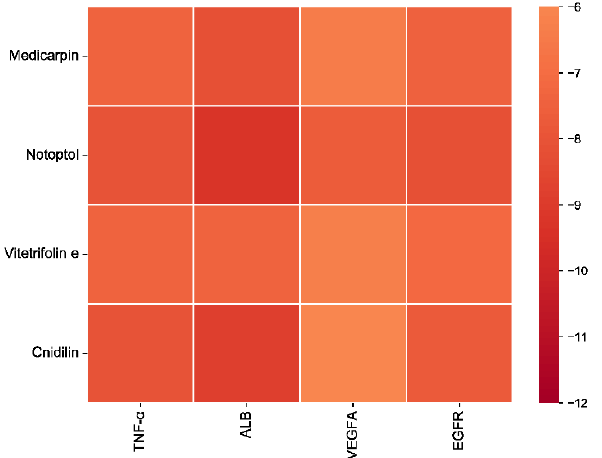
Figure 6. The heat map of the docking Vina scores. Table 1. Molecular docking parameters and results for the composition of QHSSD and its